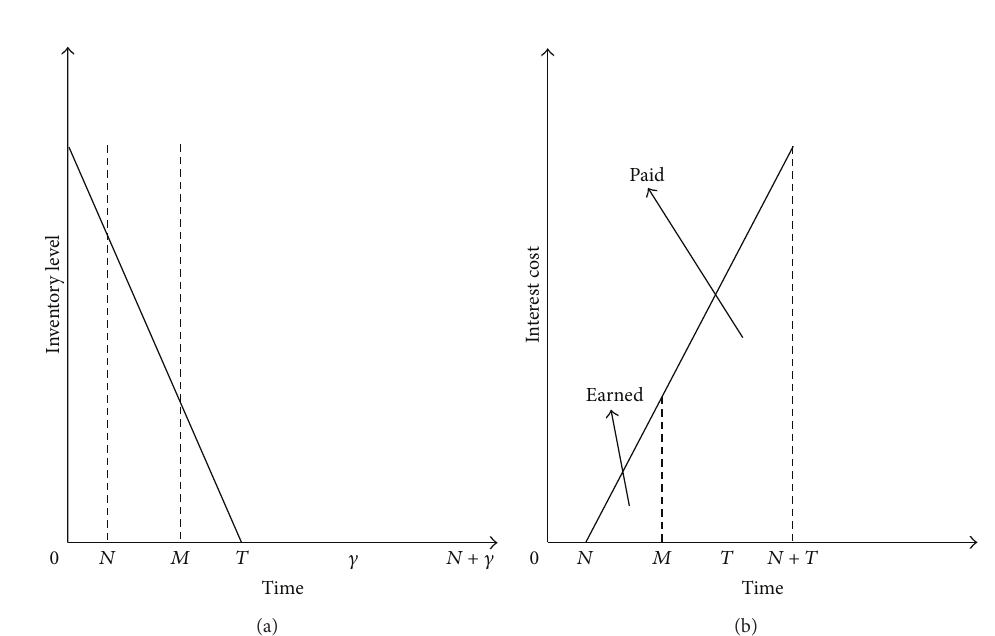
Figure 5: Inventory system for Case 2 when 𝑇 ≤ 𝑀 − 𝑁 .